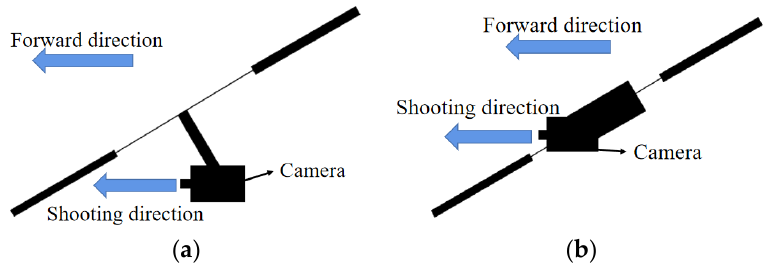
Figure 1. Camera installation for forward flight. ( a )Traditional MAV; ( b ) V8 Octorotor